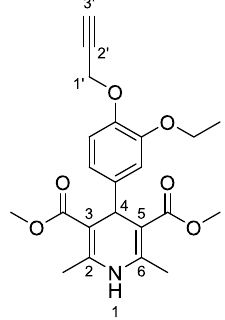
Figure 6. Chemical stucture of 3e .